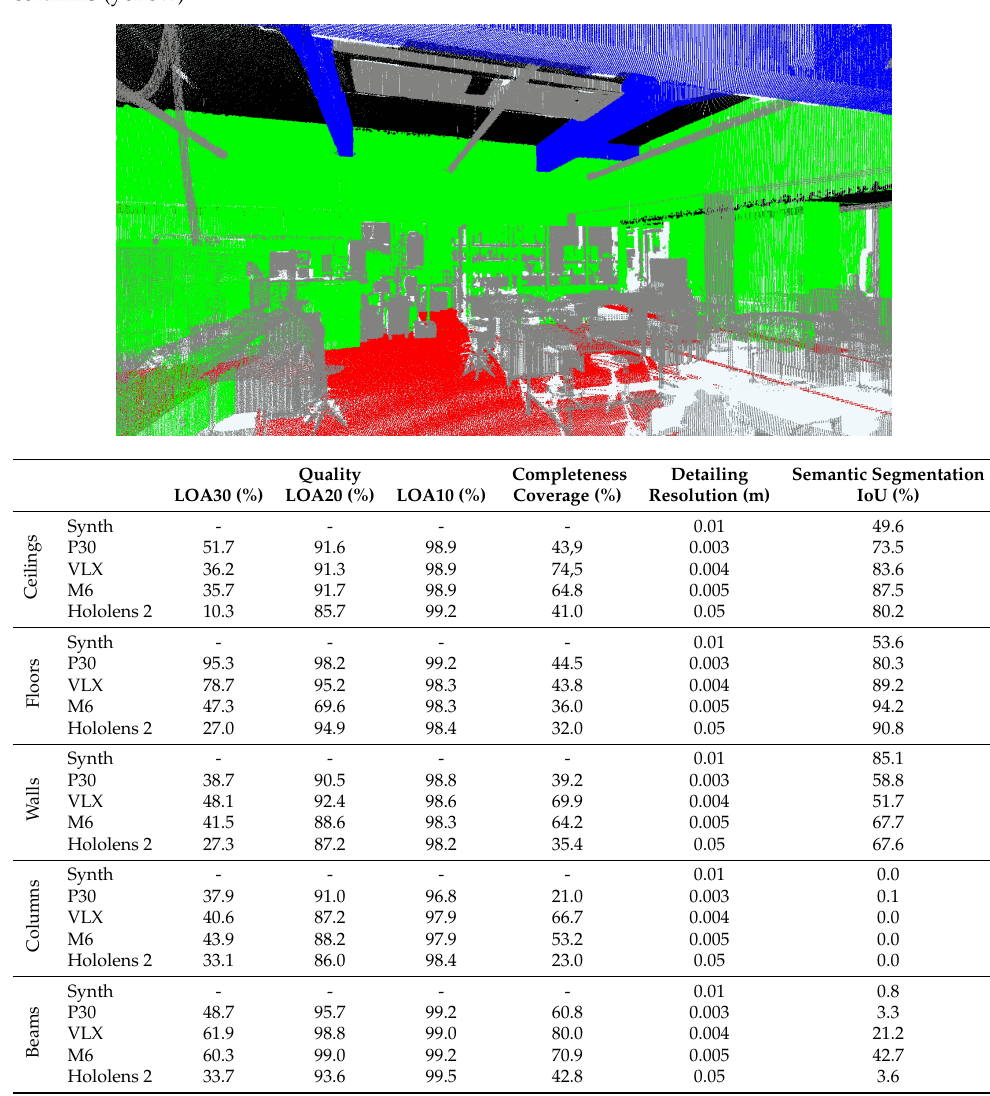
Table 5. Results of the point cloud and semantic segmentation testing (Lab 2): Comparative study of the input-validation parameters. Ceilings (black), floors (red), walls (green), beams (blue), and columns